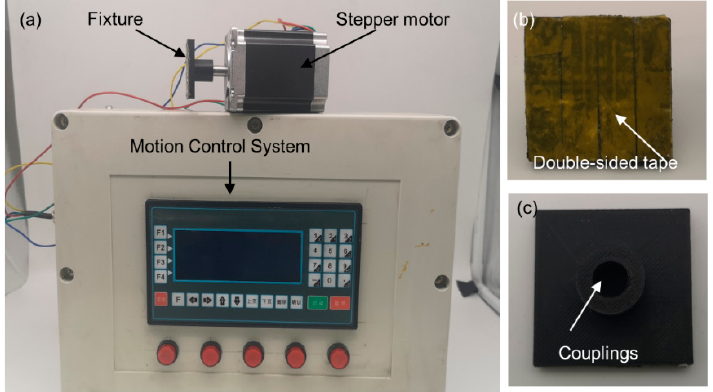
Figure 6. ( a ) The overall view of the turntable. ( b ) Front view of two clamps. ( c ) Back view of the two clamps.